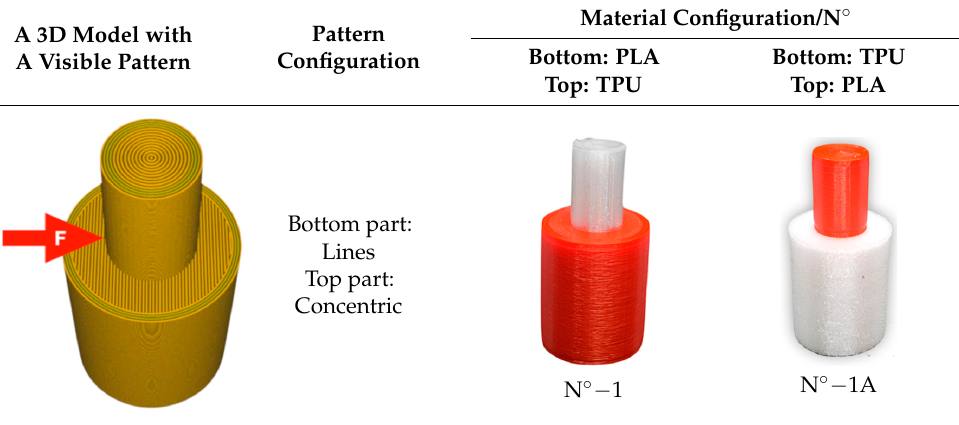
Table 3. 3D model of the printed parts with force point variants, pattern and material configurations, and the number of printed samples.